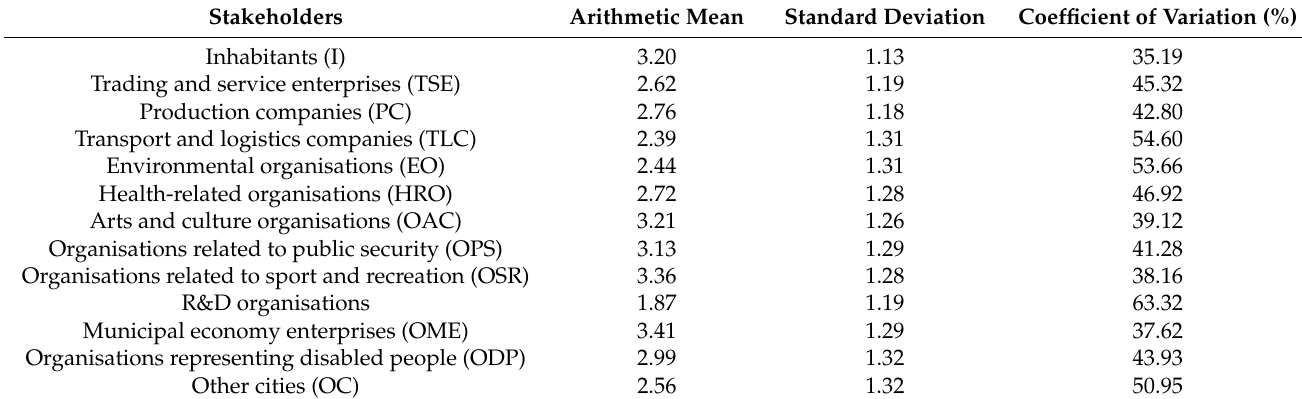
Table 4. Evaluation of cooperation between Polish cities and stakeholders.